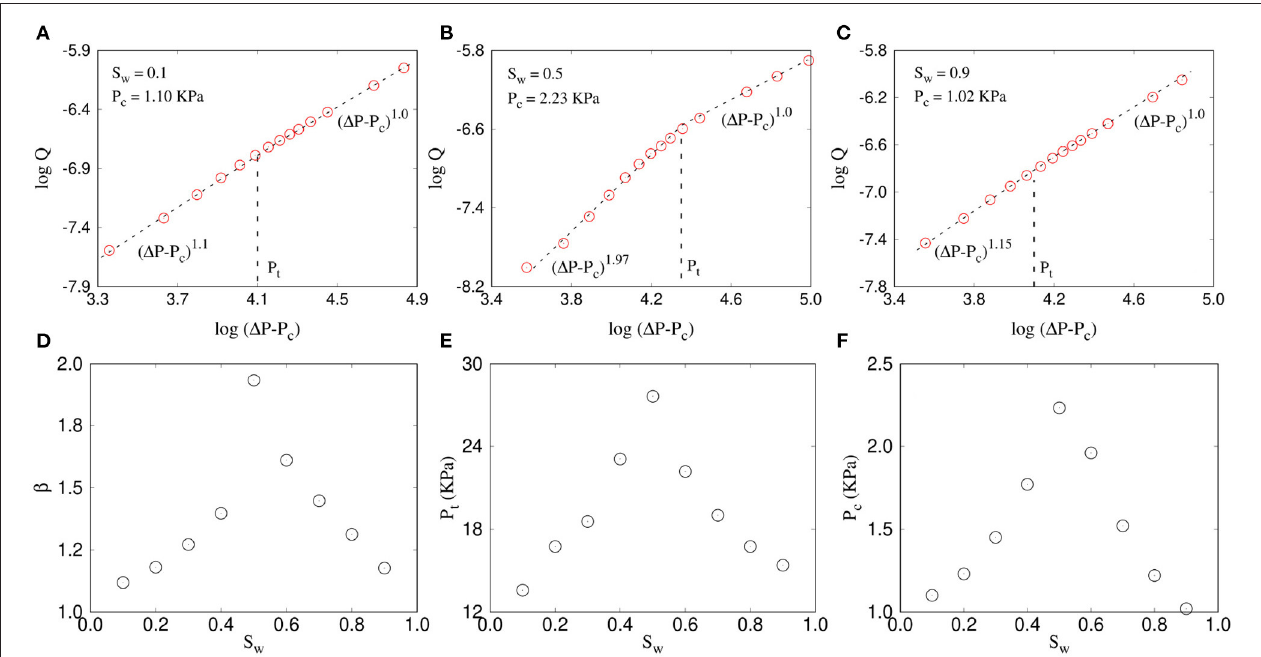
P c (Pa) vs. Q (m 3 / s) for a network of 64 FIGURE 3 | Plot of 1 P 64 links in 2D for three different wetting saturations S w − × respectively. The plots show a non-linear regime at low pressure drop and a liner regime at high pressure drop. The variations of the slopes β in the non-linear regime, the crossover pressure drop P t (KPa) and the threshold pressure P c (KPa) as a function of S w are shown in (D–F) , respectively. All the β , P t , and P c have a maximum around S w 0.5 and decreases on either =